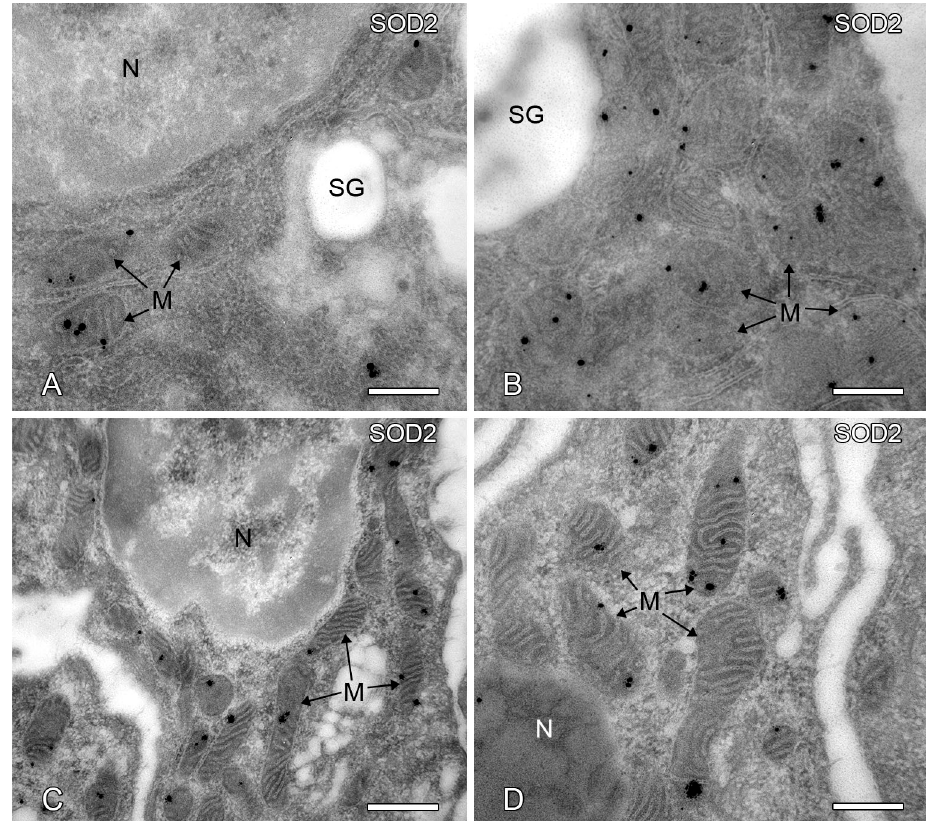
Figure 7. Ultrastructural immunocytochemical localization of SOD2 in human parotid gland tissues. Electron microscopic immunocytochemical localization of the SOD2 protein in human parotid gland acinar ( A , B ) and striated duct cells ( C , D ) in the ultrathin sections with ultra-small nanogold on LR white sections. Arrows depict mitochondria; SG: secretory granules; N: nucleus; M: mitochondria. Bars represent: 1 µm ( A , C ); 0.5 µm ( B , D ). 2.8. Peroxisome Proliferator-Activated Receptors (PPARs) Are Highly Expressed in the Parotid Gland